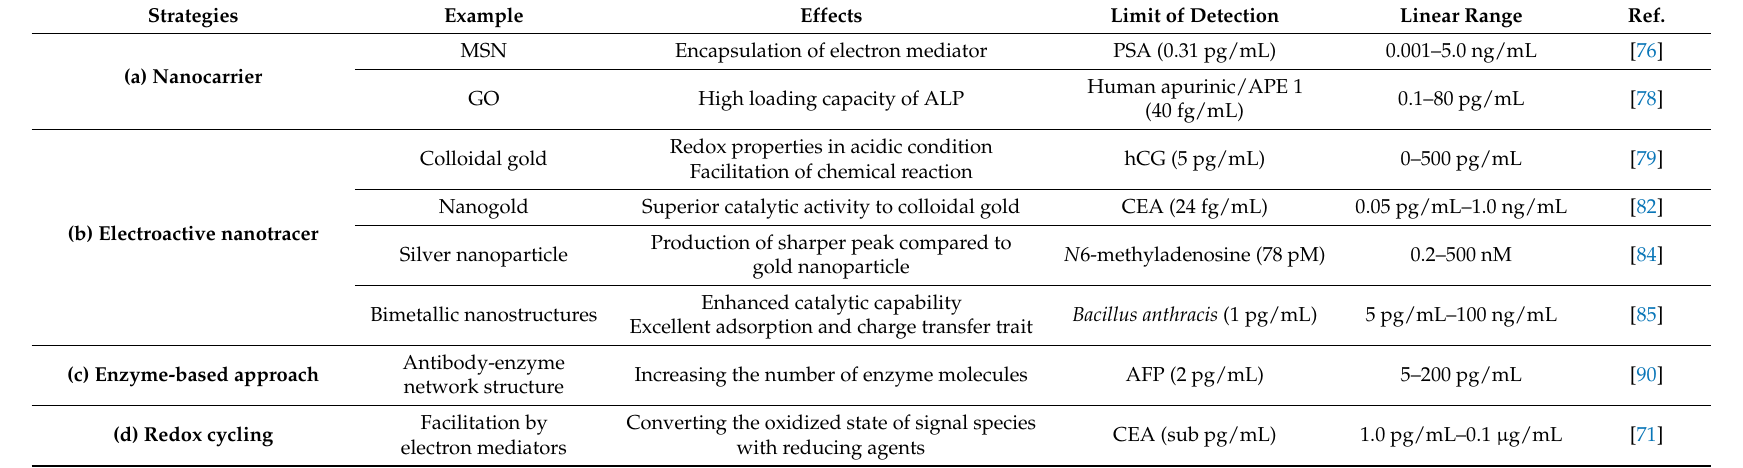
Table 2. Summary of labeling strategies associated with nanomaterials for signal enhancement. Abbreviation: Mesoporous silica nanoparticle (MSN); Graphene oxide (GO); Alkaline phosphatase (ALP); Prostate-specific antigen (PSA); Apyrimidinic endonuclease (APE); Human chorionic gonadotropin (hcG); Carcinoembryonic antigen (CEA); Alpha-fetoprotein